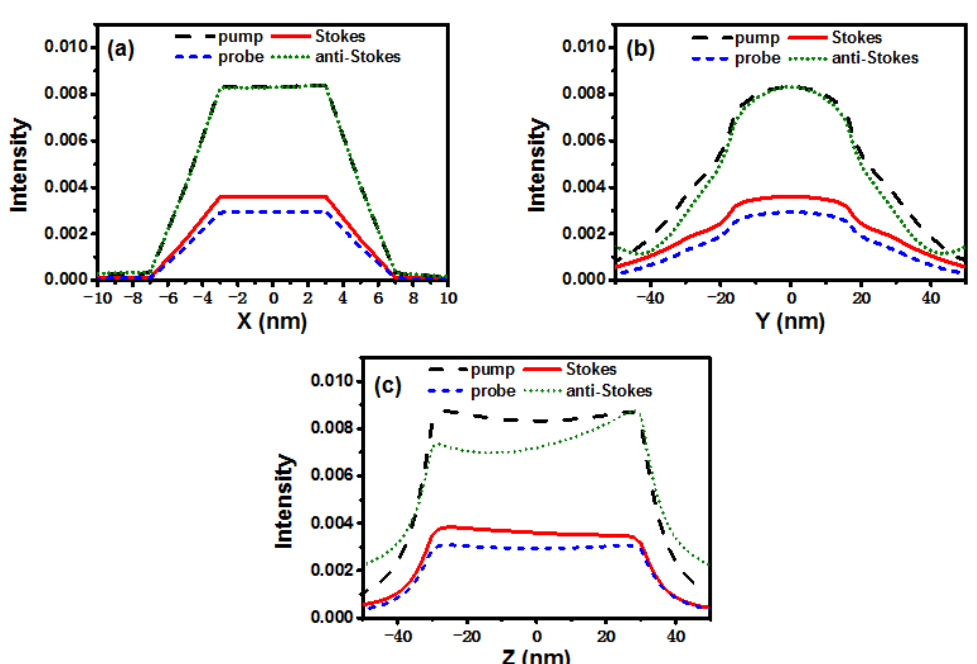
Figure 8. Transient distributions of the electric field of ( a ) pump, ( b ) Stokes, ( c ) probe, ( d ) anti-Stokes light, and ( e ) the corresponding SECARS map at 7128.3 fs. The white box in ( e ) is an enlarged view of the area of 60 nm × 60 nm in the center of the disk-ring structure.